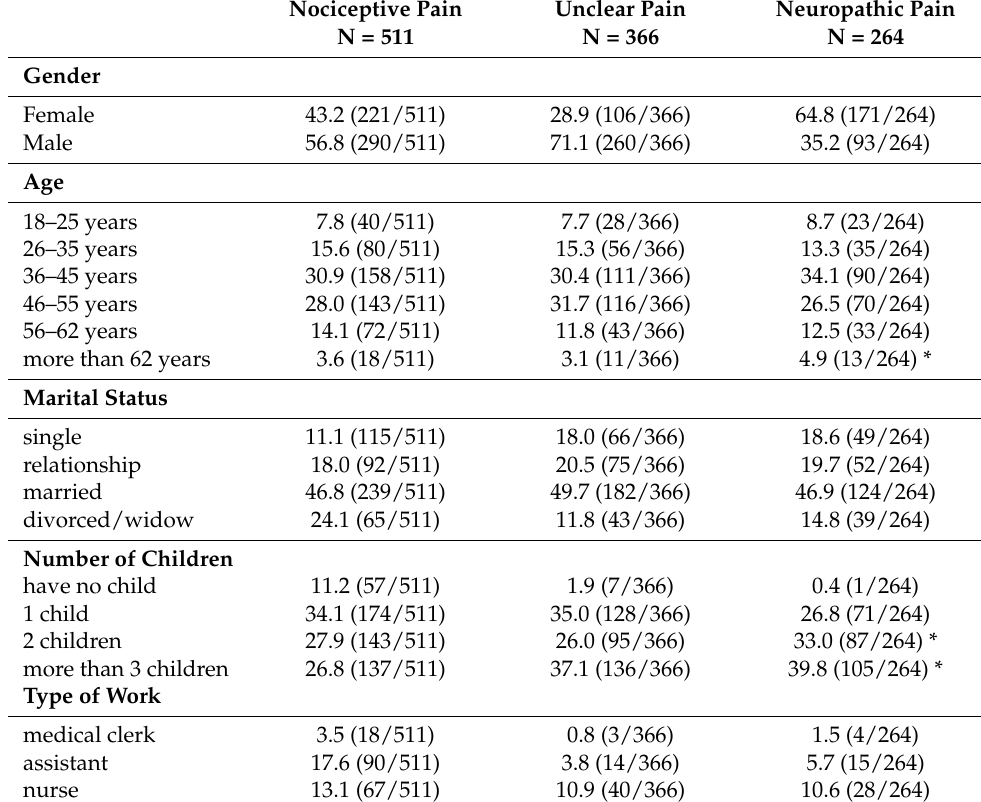
Table 3. Demographic factors associated with neuropathic low back pain, * p <